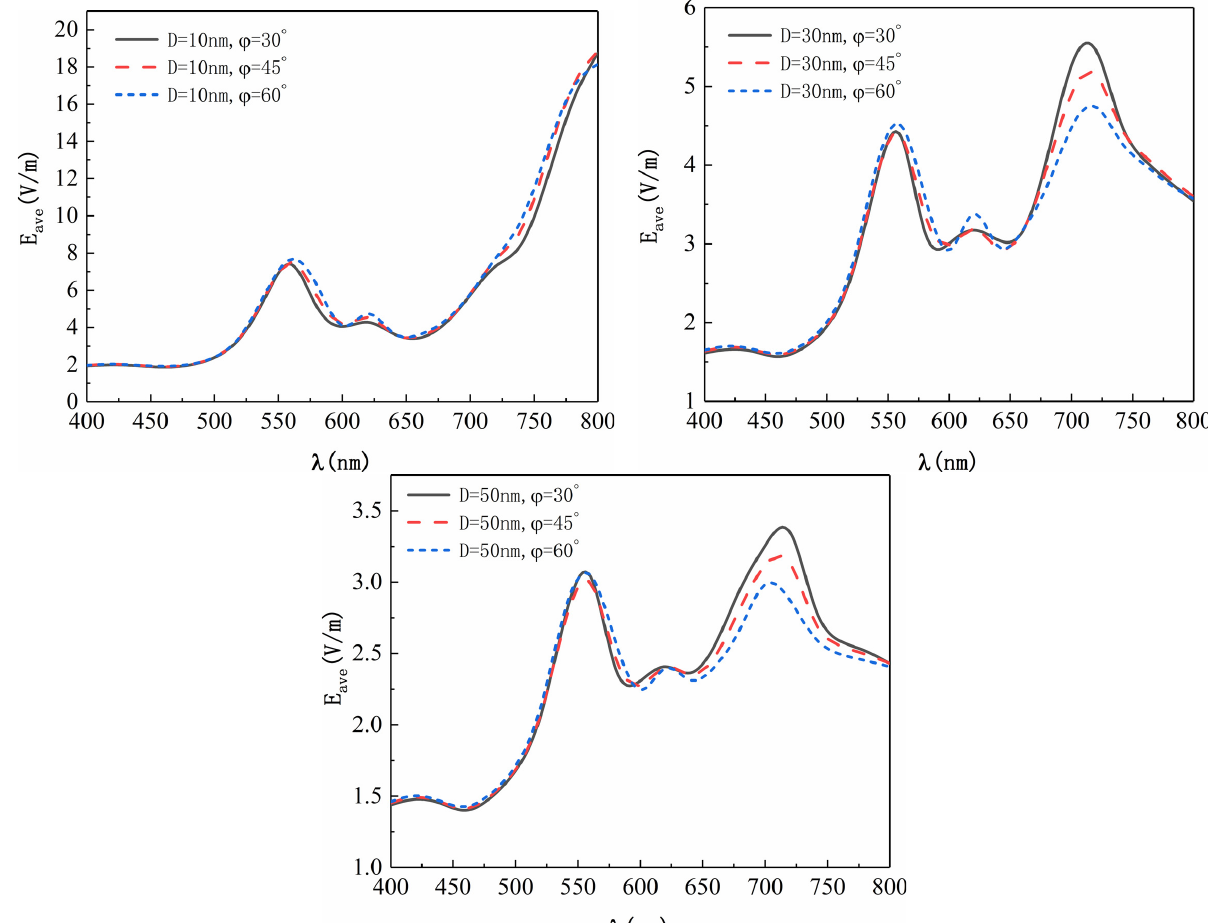
Figure S1: Curve of average electric field enhancement with the working wavelength ( E 0 is the amplitude of the incident Gaussian beam; | E ave | is obtained by averaging | E | in the whole space